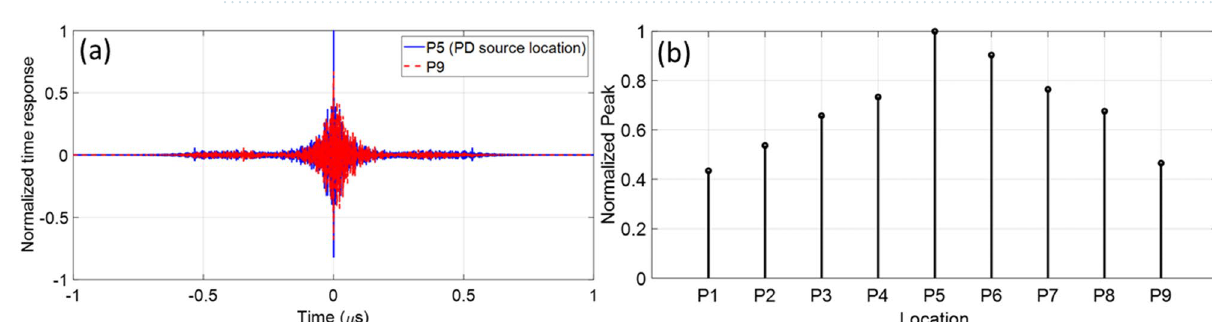
Figure 12. ( a ) Time reversed responses for two guessed locations, P 1 and P 9 . In this scenario, the metallic object is removed. The location of P 5 is considered as the ground truth PD source location. ( b ) The normalized peak values of the time reversed response at the guessed locations P 1 to P 9 . In this scenario the metallic object is removed. The location of P 5 is considered as the ground truth PD source